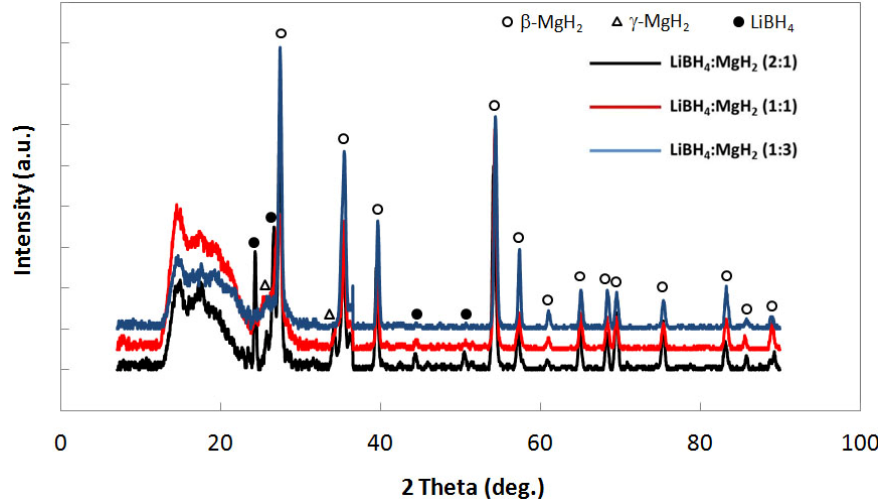
:MgH in 2:1, 1:1 and 1:3 molar ratios. 4 2